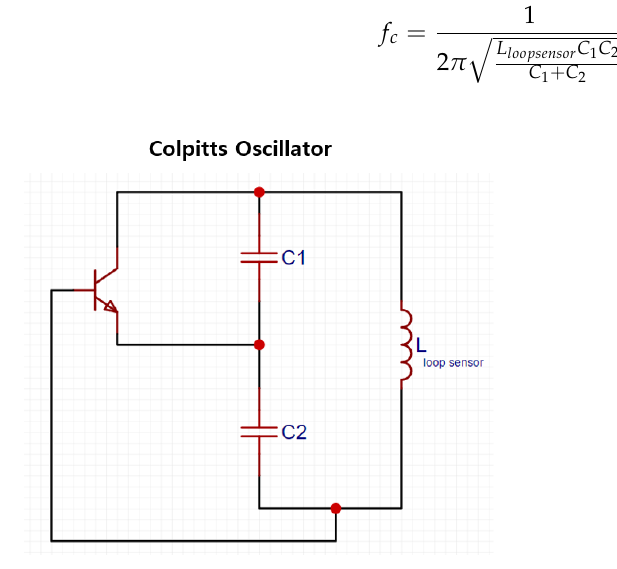
Figure 2. Colpitts oscillator circuit.